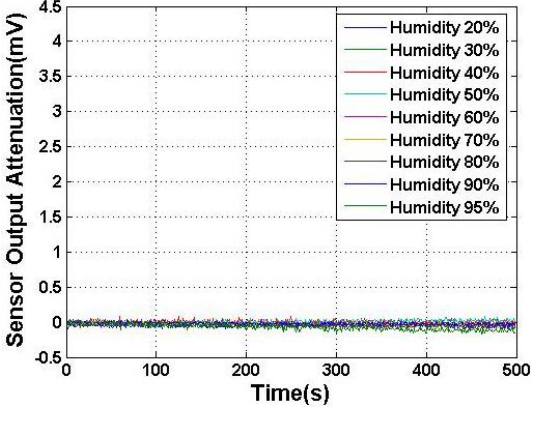
Figure 6. Sensor output caused by field attenuation after package surface